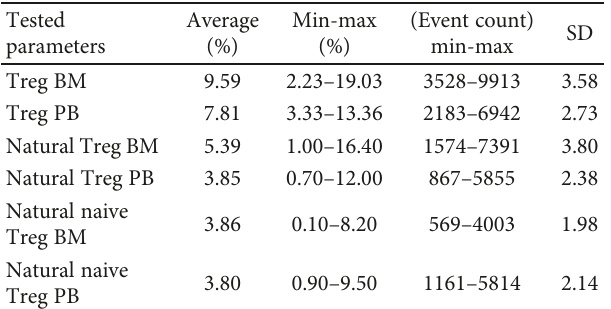
Table 2: Distribution of tested parameters in the bone marrow and peripheral blood in children at diagnosis of ALL.